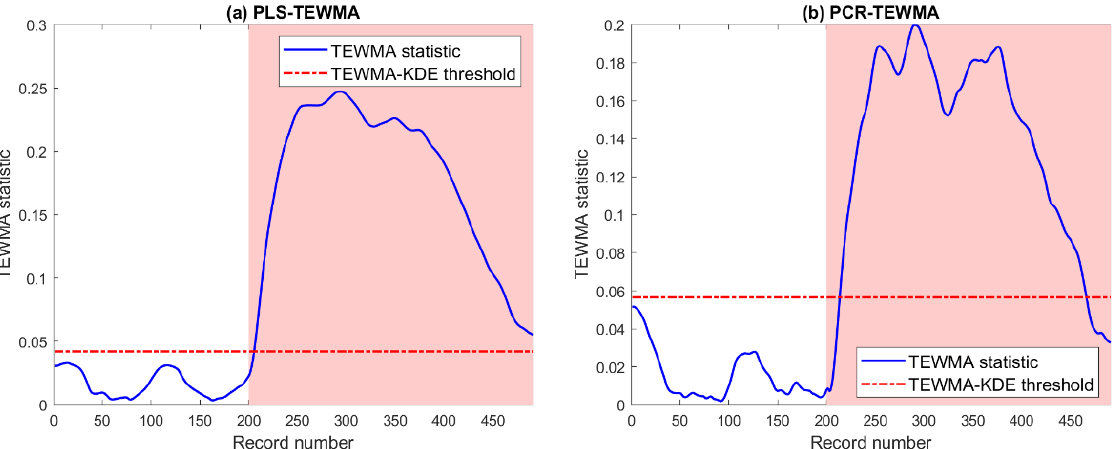
Figure 17. Detection results of ( a ) PLS- and ( b ) PCR-based TEWMA charts in the presence of sensor bias fault in the pyranometer measurements (a bias of 10% of the total variation in solar irradiance measurements). Table 7. Results of PLS- and PCR-based TEWMA charts under bias sensors fault in pyranometer. Bias